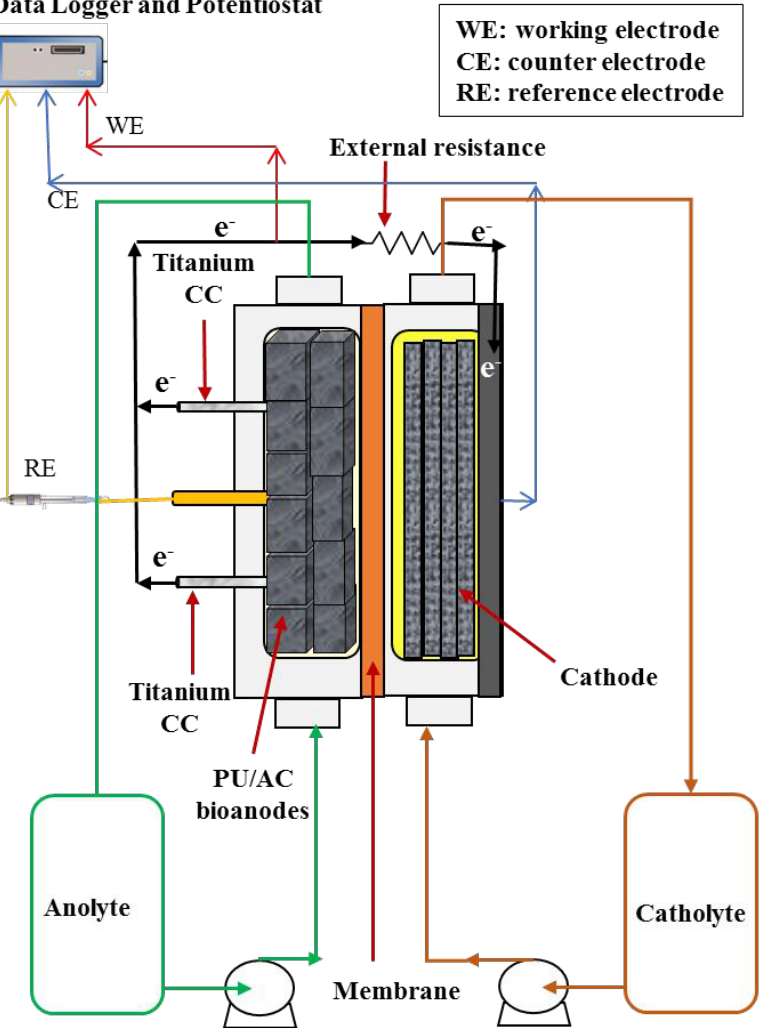
Figure 1. Schematic illustration of the experimental set-up (MFC reactor). The number of PU/AC composites in the anode is 11 cubes. All PU/AC cubes were physically connected.